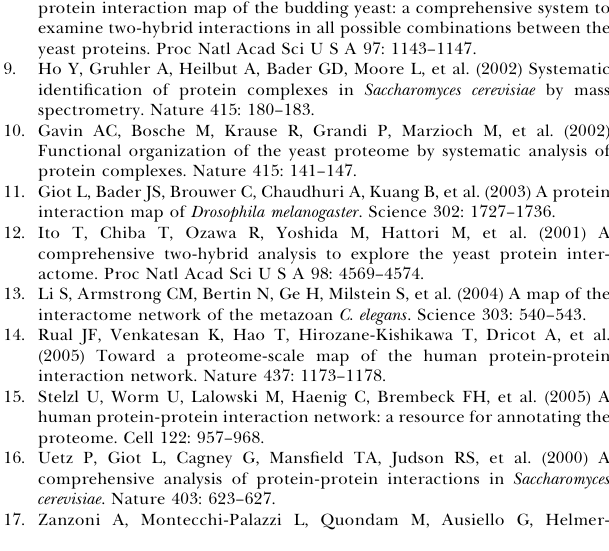
Figure S1. Protein Degree–Centrality Scatter-Plots Log-log scatter-plots of each protein contained within the three networks used in this study: (A) the whole human PPI network (11,463 proteins), (B) the high-throughput human PPI network (4,986 proteins), and (C) the manually curated human PPI network (8,704 proteins). The x -axis is the degree and the y -axis is the centrality of a protein within its respective network. Found at doi:10.1371/journal.ppat.0040032.sg001 (2.5 MB TIF). Table S1. Relative Node Occurrences Relative occurrences of four types of nodes in each of the three networks: Whole human PPI network (W), the human PPI network yielded by High-Throughput experiments (HT), and the human PPI network consisting only of Manually Curated PPIs (MC). The ‘‘ Fraction ’’ column defines the cutoff at which a protein is considered a hub or a bottleneck. The other columns represent the fraction of hub-bottleneck, non-hub-bottleneck, hub-non-bottleneck, and non- hub-non-bottleneck proteins in the network using that cutoff. Table S2. Detailed GSEA Results Summary of GSEA results with and without human-HIV interactions for three networks: Whole human PPI network (W), the human PPI network yielded by High-Throughput experiments (HT), and the human PPI network consisting only of Manually Curated PPIs (MC). We report p -values only for the sets of human proteins in Figure 3. The ‘‘ #proteins in group ’’ column displays the total number of